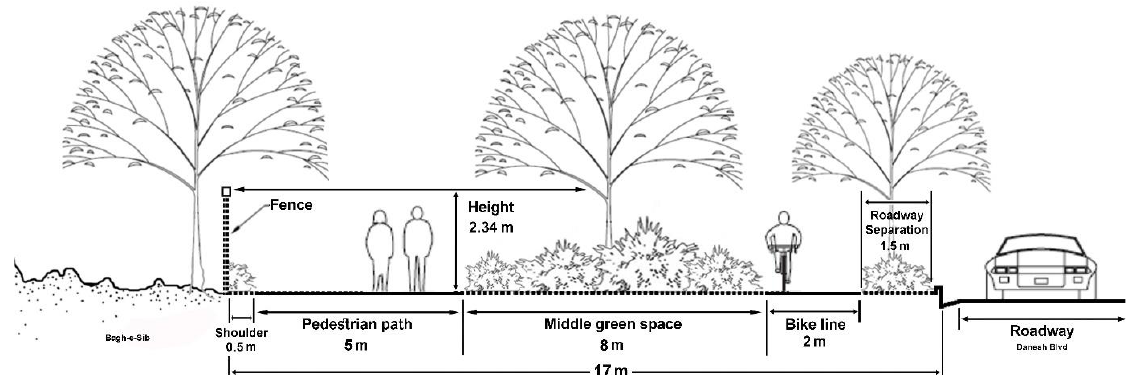
Fig. 3: Cross-section of Danesh Pedestrian and Bicycle Path illuminating its segments and dimensions